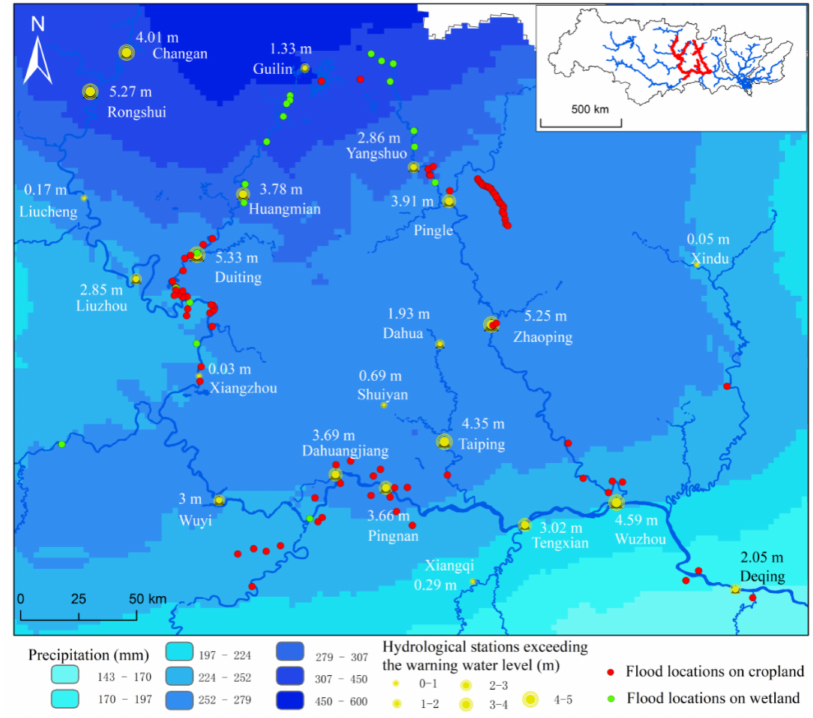
Figure 10. Flood monitoring results derived from Sentinel-1 images and hydrological data. Although the Sentinel-1 images could cover the whole PRB, some flood locations have not been monitored by Sentinel-1 images yet. For example, at Rongshui, Zhaoping and Changan, the observed highest water levels are 5.27 m, 5.25 m and 4.01 m higher than their corresponding warning water levels, but failed to be identified by Sentinel-1 images. There were two probable reasons for this phenomenon. One reason could be that the hydrological stations were located in a very narrow valley, and Sentinel-1 images failed to monitor the water body due to its spatial resolution of 10 m. For instance, combining Figures 8 and 10, we can find that Zhaoping Hydrological Stations were located in a very narrow valley, which limits the Sentinel-1 SAR observation due to the terrain effects. Another reason could be the relatively low time resolution of Sentinel-1 images. As shown in Figure 11, at Rongshui Hydrological Station, the flood peak happened on 2 July 2017, with 5.27 m exceeding the warning water level. On 3 July 2017 (sensing date of Sentinel-1 image), the water level already dramatically dropped to 1.57 m below the warning water